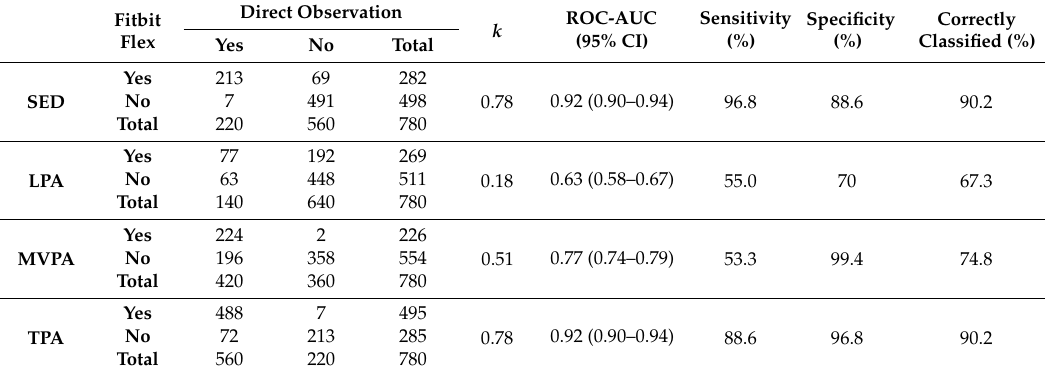
Table 4. Agreements in activity intensity classifications between direct observation and Fitbit Flex, kappa, receiver operating curve (ROC-AUC), sensitivity, and